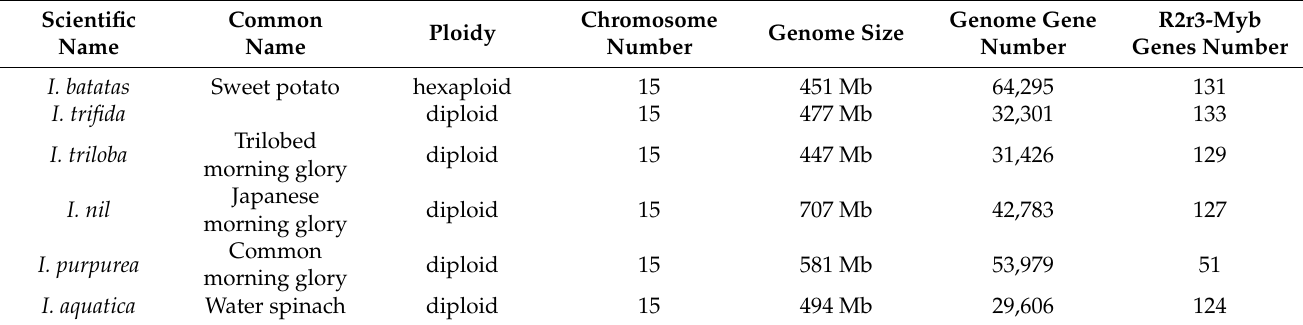
Table 1. Genomic information and identified R2R3-MYB gene numbers in six Ipomoea species.